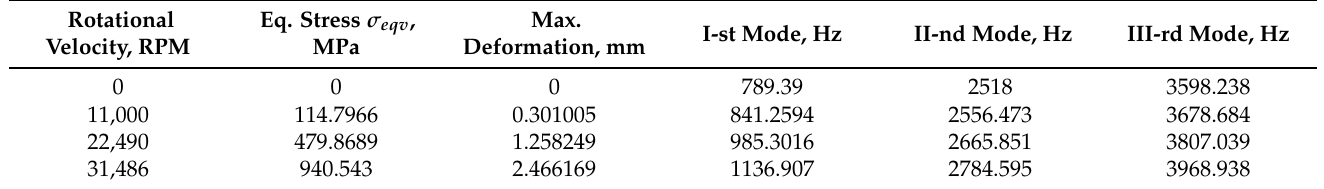
Table 3. Summary of the results of numerical SP analysis (with no aerodynamic loads consideration).